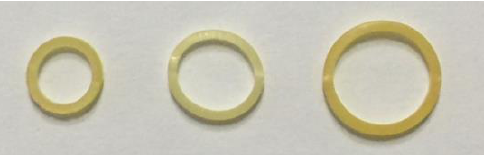
Figure 1. 3/16”, 1/4”, and 5/16” 5-oz elastics Energy Pak™ from Rocky Mountain